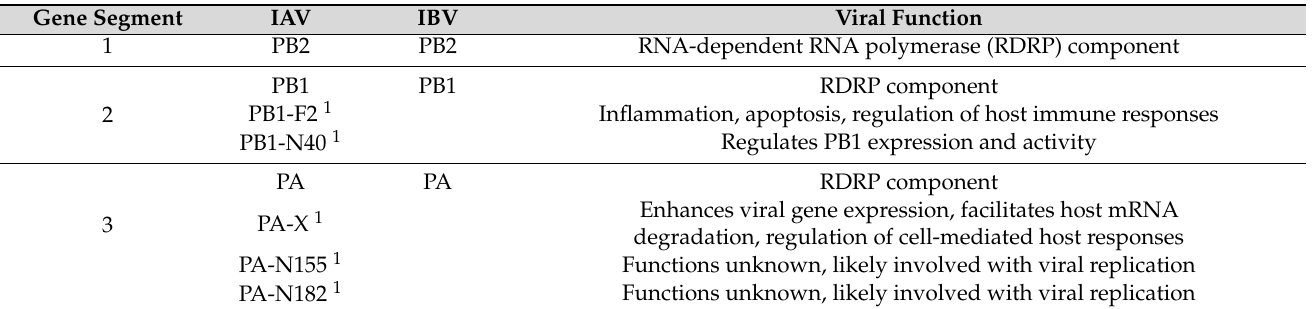
Table 1. Influenza virus genes and proteins. Gene segments are listed for influenza A virus